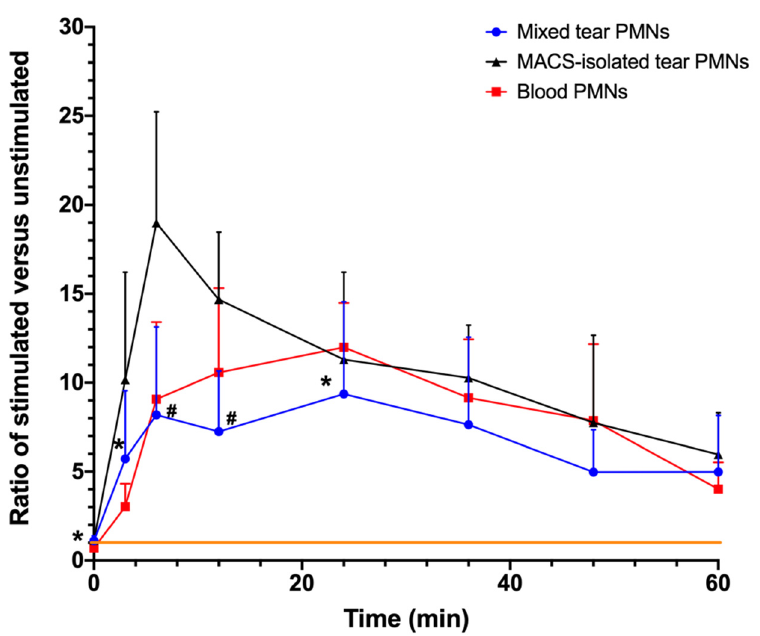
Figure 5. Changes in chemiluminescence (CL) of PMA-stimulated PMNs. Results are reported as ratio of PMA-stimulated PMNs CL emissions over control (unstimulated PMNs) CL emissions. A total of 50,000 cells/well were transferred to wells containing 1 mM luminol and HBSS followed by the addition of 2 μ M PMA. Generation of ROS was measured over time using the Cytation 5 at 37 °C. The orange line represents a ratio of 1, meaning no difference between stimulated and unstimulated CL values. Values are presented as means ± standard deviations; mixed tear PMNs (n = 21 from 18 participants), MACS-isolated tear PMNs (n = 10 from 7 participants), and blood PMNs (n = 7 from 4 participants). * Significantly different from the ratio of blood PMNs ( p ≤ 0.04); # significantly different from the ratio of MACS-isolated tear PMNs ( p ≤ 0.001).